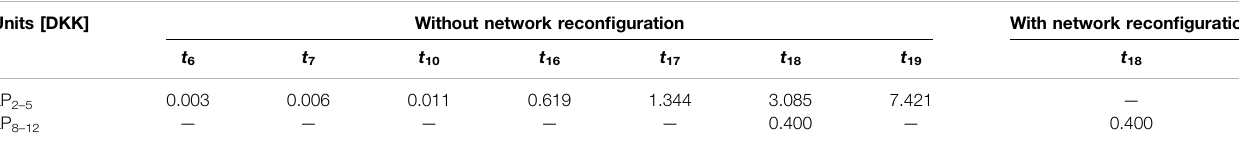
TABLE 3 | DTS at load points with and without network recon fi guration in scenario 2. Units